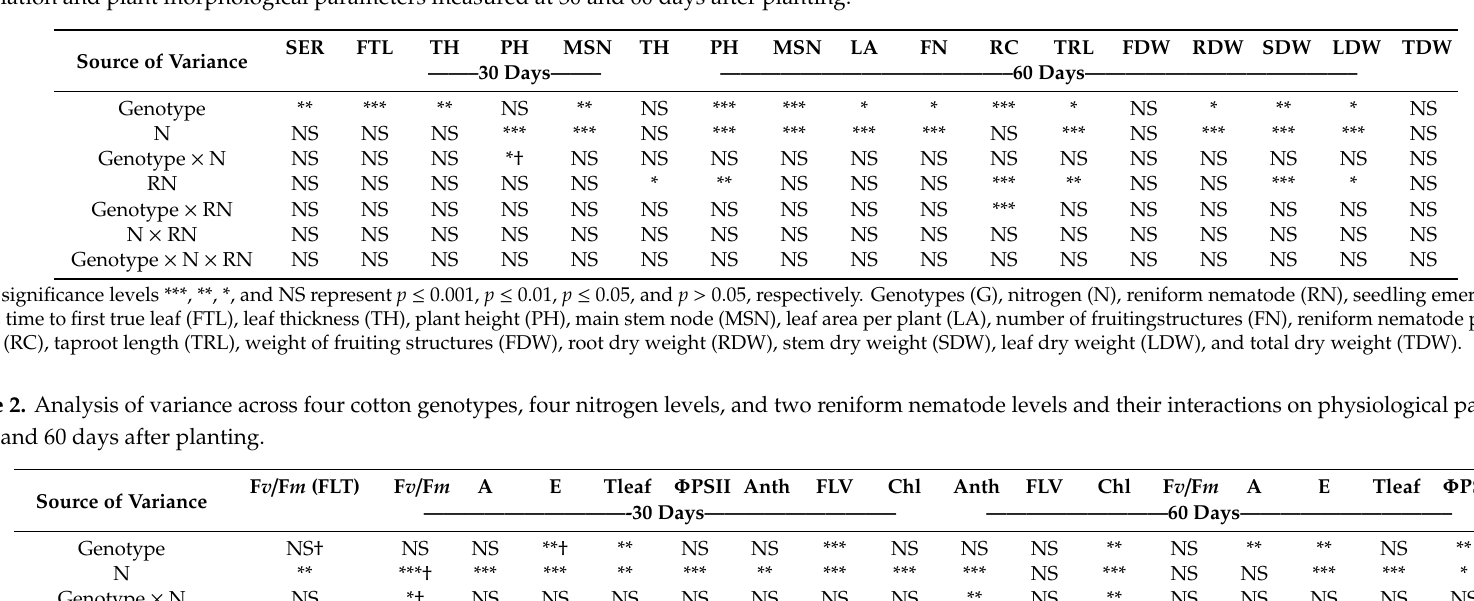
Table 1. Analysis of variance across four cotton genotypes, four nitrogen levels, and two reniform nematode levels and their interactions on reniform nematode population and plant morphological parameters measured at 30 and 60 days after planting.